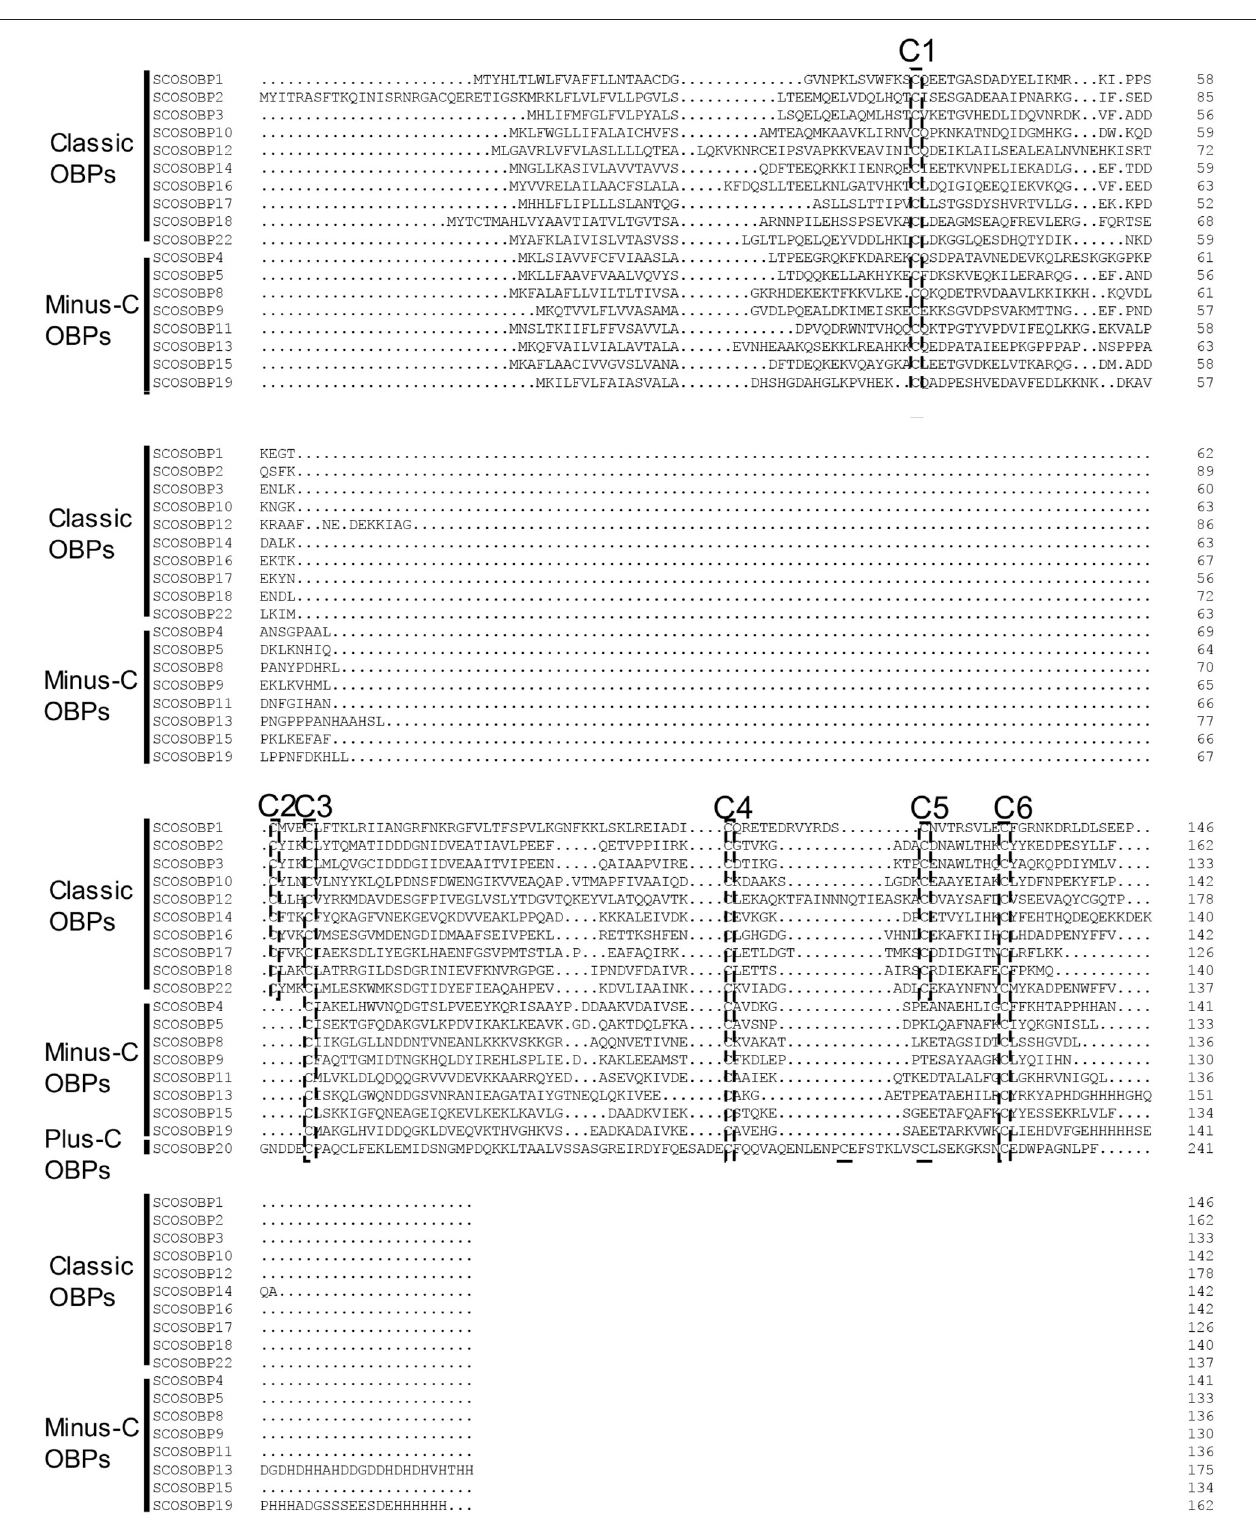
FIGURE 3 | Sequence alignment of candidate ScosOBPs. The six conserved cysteine residues are marked as C1–C6.